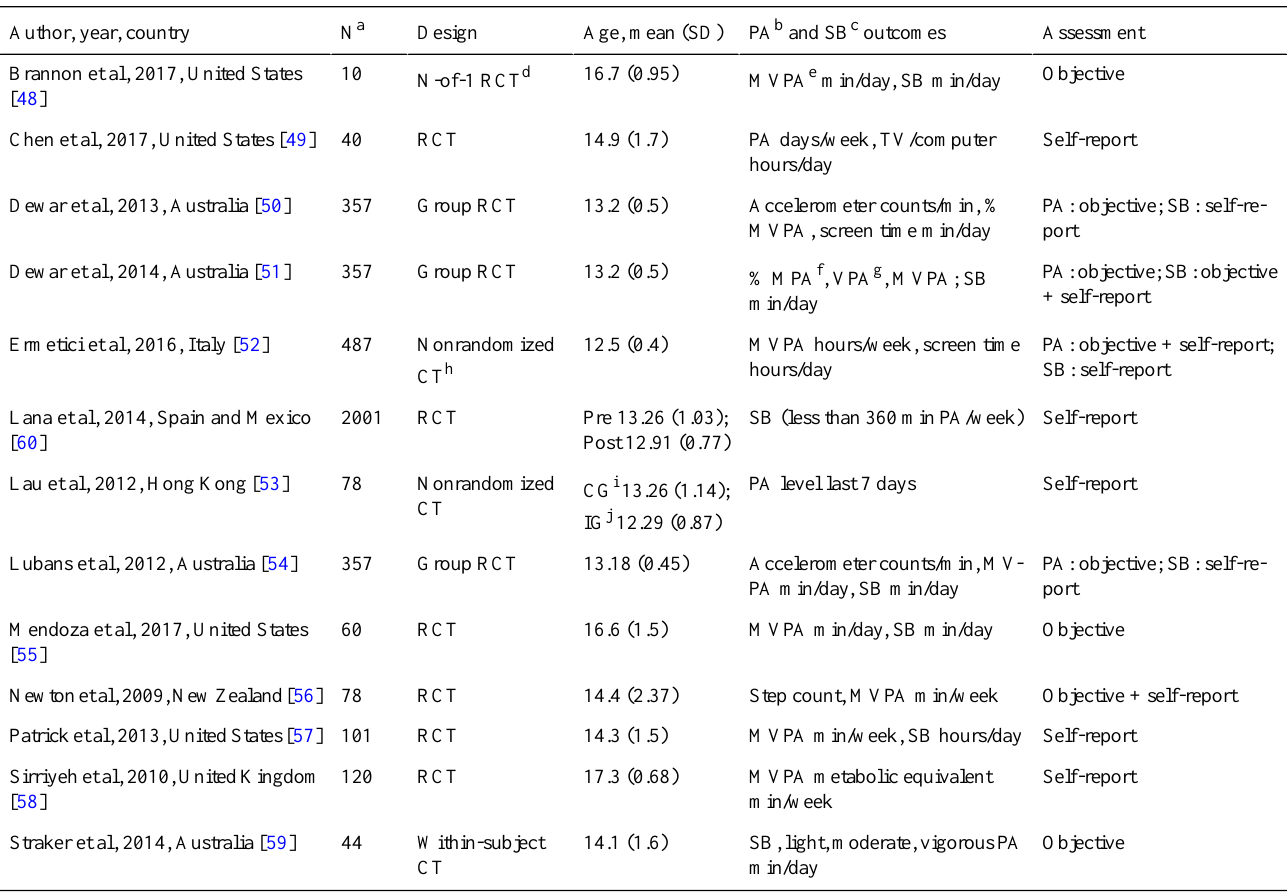
Table 2. Study characteristics of included studies—sample and outcomes.